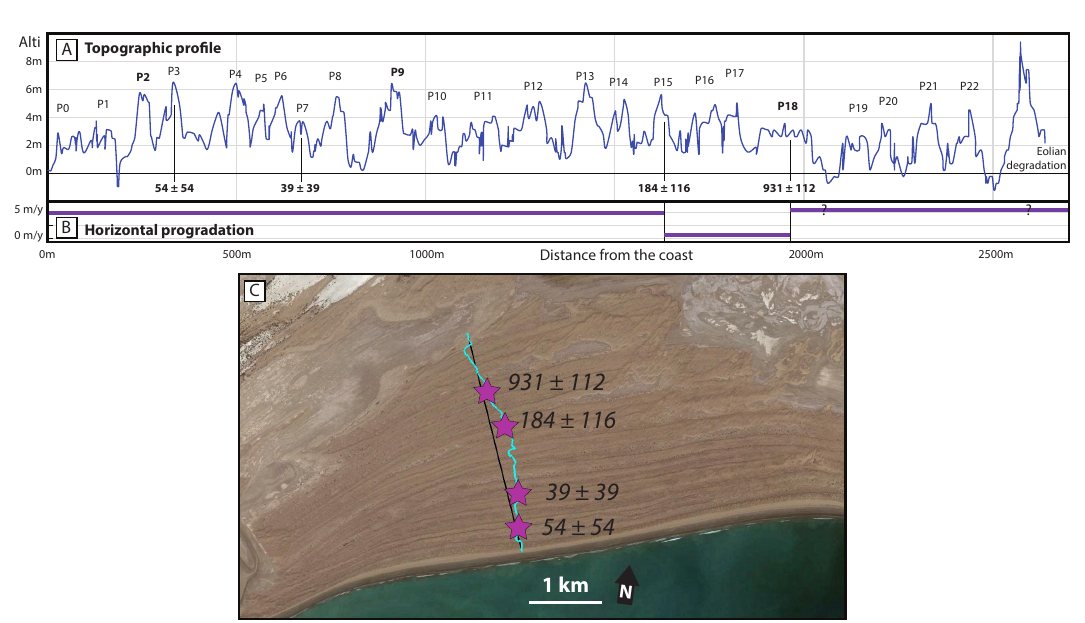
Figure 9. Pozm Bay topographic profile. ( A ) Topographic profile through the beach ridge succession (see Figure 9C). No obvious step-like topography can be detected. ( B ) Horizontal progradation rate from dated ridges. ( C ) Satellite view of Pozm Bay profile (Figure 9A). Image Google Earth, 25.39 ◦ N, 60.24 ◦ E. The profile is projected on the black line (see Supplementary Table